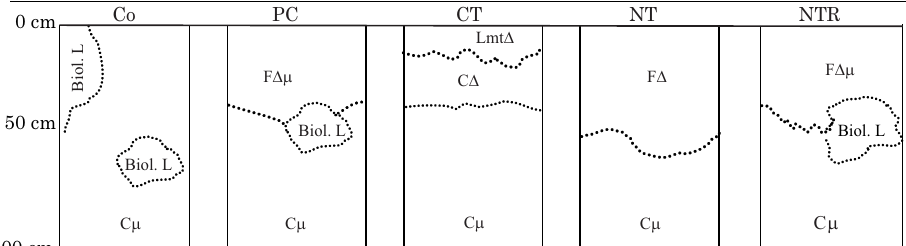
Figure 1. Representative drawing of the organizational mode of the structural units (Biol.L, L, C, F) and the internal state of the structural units µµ µµµ , ∆µ∆µ ∆µ∆µ∆µ and ∆∆ ∆∆∆ , which constitute the different morphologically homogeneous structural units indicated by the crop profile analysis of the Red Latosols under native forest and the different management systems. Co: control (native forest), PC: perennial crop, CT: conventional tillage, NT: no-tillage cultivation, NTR: no-tillage crop rotation, Biol.L: biological activity, C µµµµµ : continuous non-compacted, F ∆µ∆µ∆µ∆µ∆µ : Fragmented cracked (fissures) with intermediate compaction level; Lmt ∆∆∆∆∆ : medium-sized loose clumps, compacted, C ∆∆∆∆∆ : continuous compacted, F ∆∆∆∆∆ : Fragmented cracked (fissures)